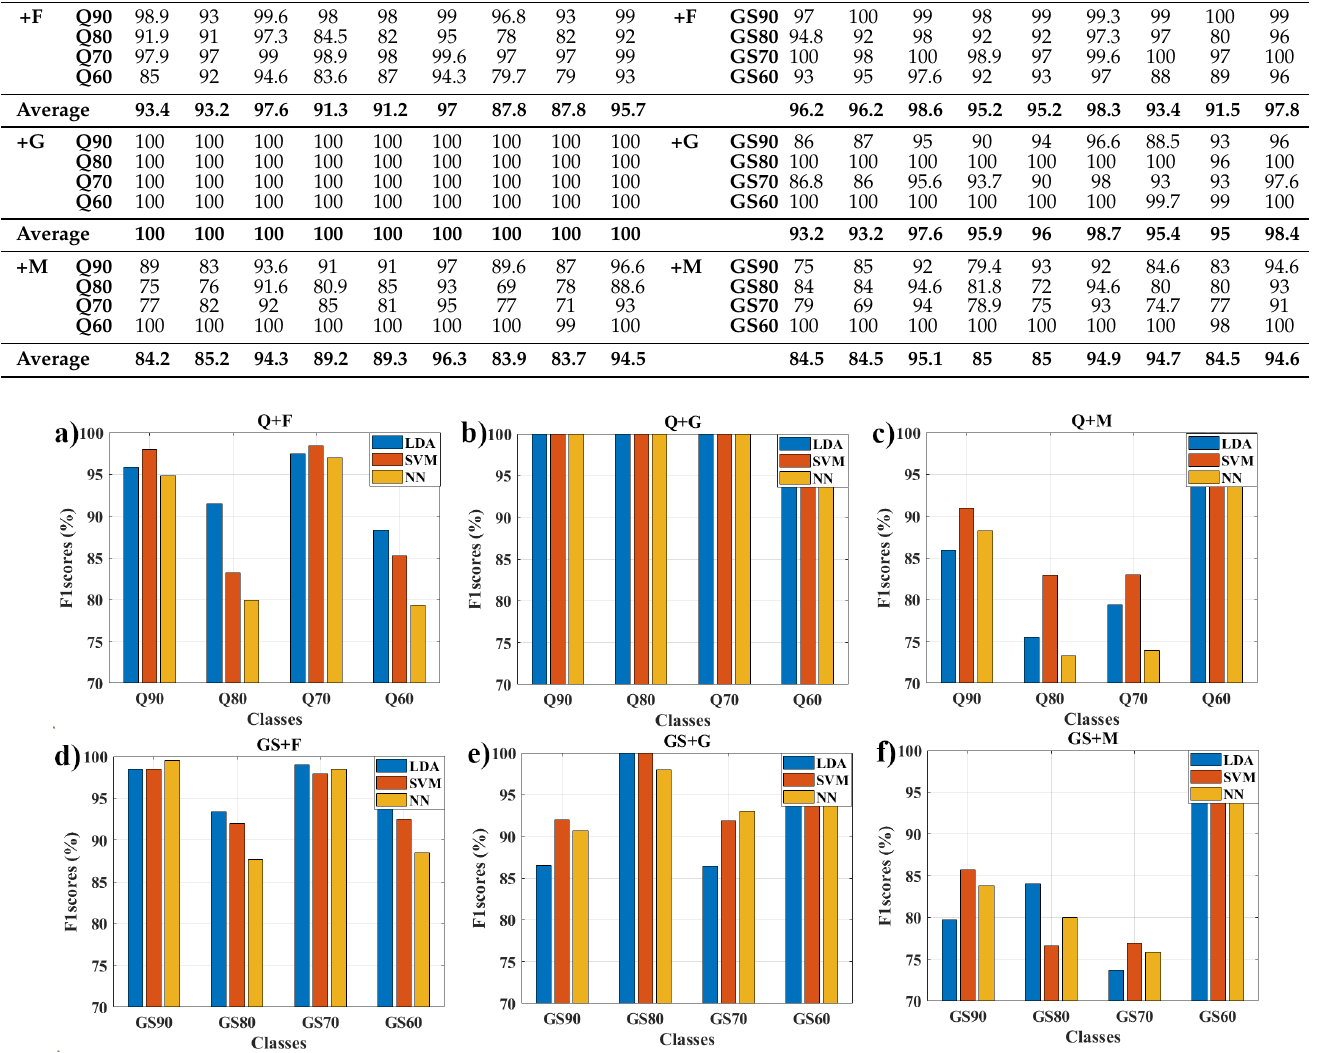
Figure 7. Bar plots for F1 scores rate (validation) of Table 2, 10-fold cross-validation results LDA, SVM, and NN classifiers using 24 coefficients. From ( a – f ) are the Q and GS honey scores with different concentration levels using F, G, and M syrups,